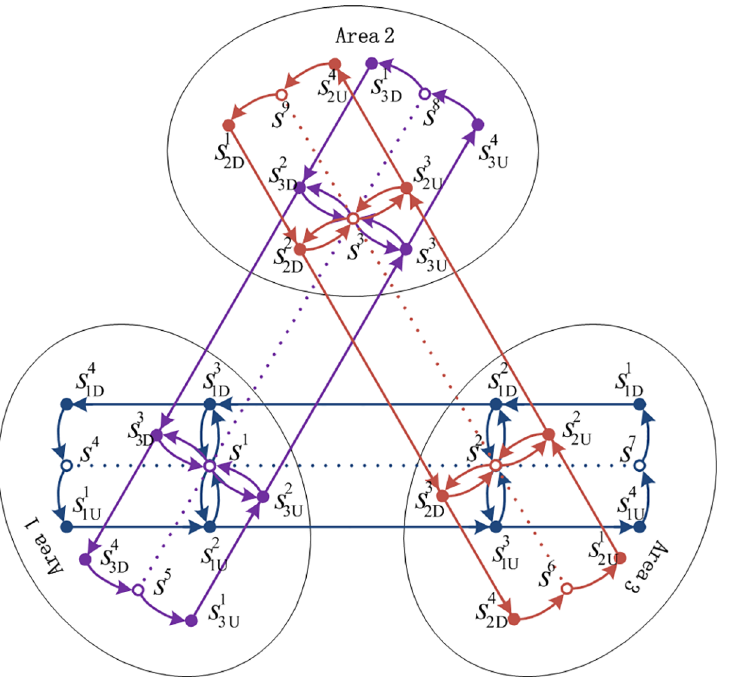
Fig 4. Three areasof the urban rail